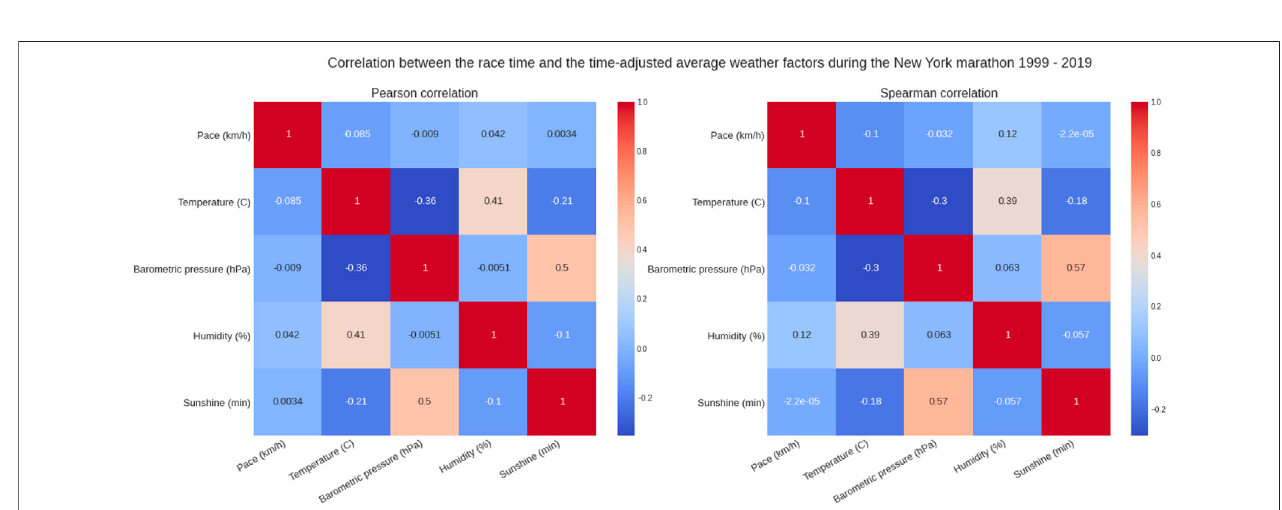
FIGURE 9 | Correlation between race times and time-adjusted weather variables.